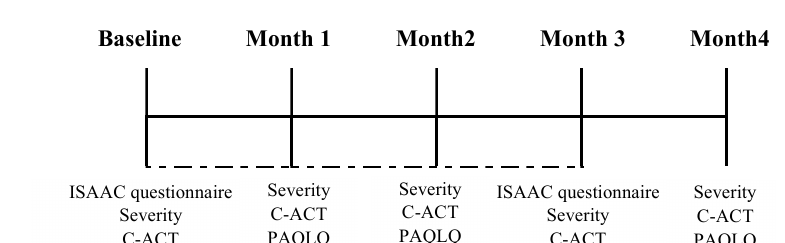
Figure 1. Consort diagram.